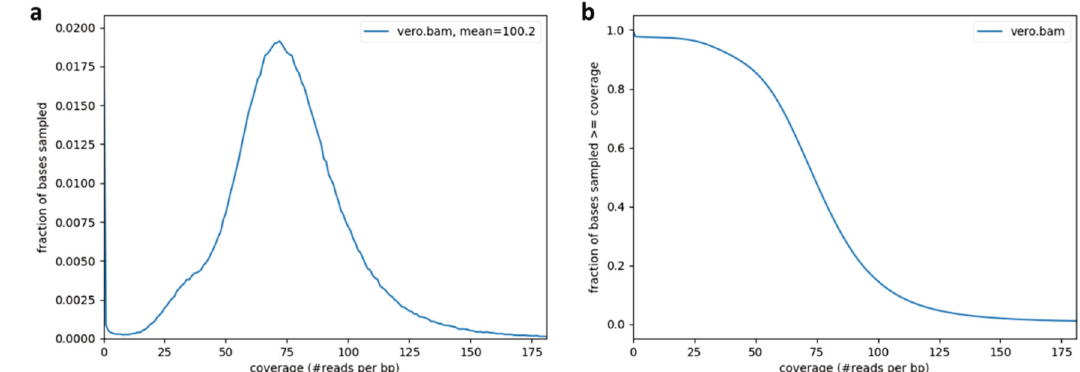
Fig. 1 Vero genome sequencing depth. a Distribution of read coverages. b Genome fractions depth of sequencing.